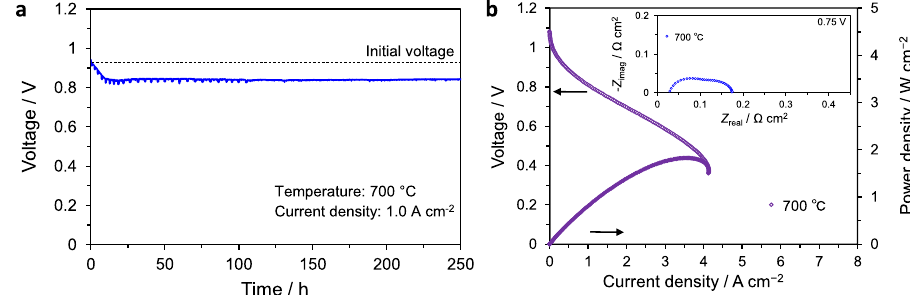
Fig. 9 Evaluation of cell performance with time. a Time-dependence of the voltage at an applied current density of 1 A/cm 2 at 700 °C. b Current – voltage ( I – V ) and current – power ( I – P ) curves evaluated at 700 °C at the end of the durability test. Inset shows the fi nal impedance spectra obtained at 0.75 V and 700